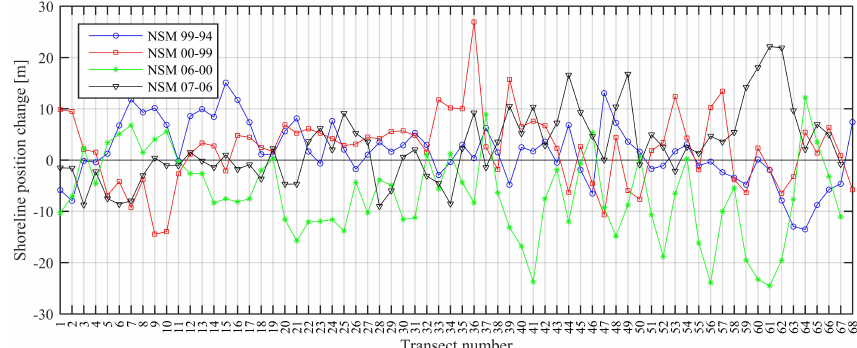
Figure 7. Comparison between the NSM relating to each period between two consecutive